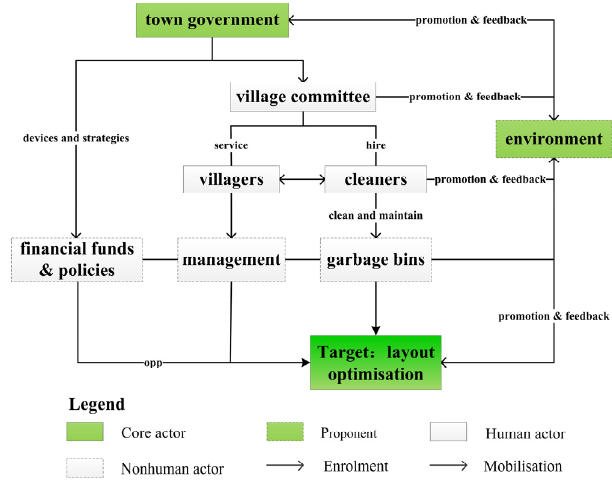
Figure 6. Construction of a heterogeneous network.